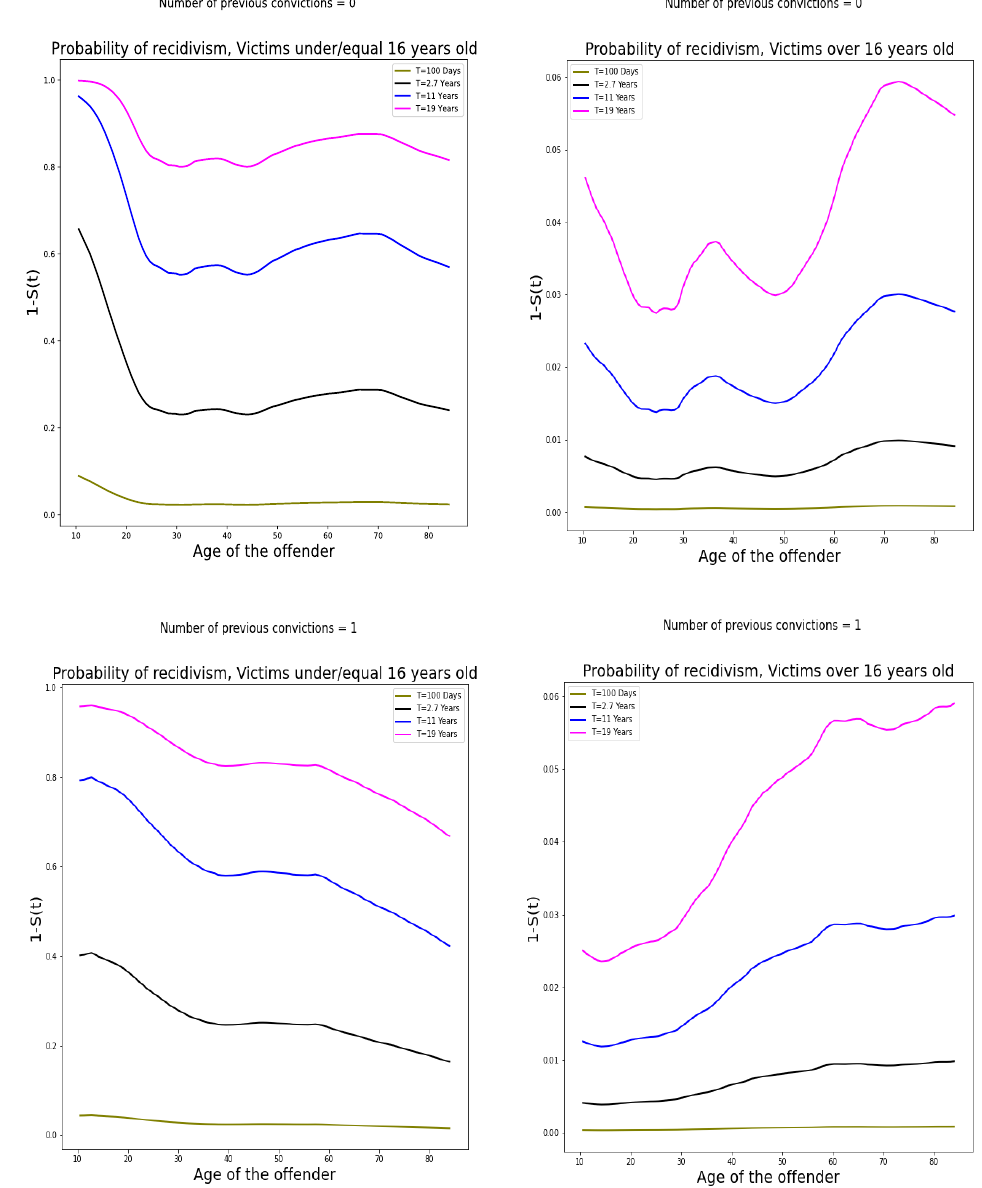
Figure 2. DeepSurv predictions of recidivism probability in different periods, for different ages and previous